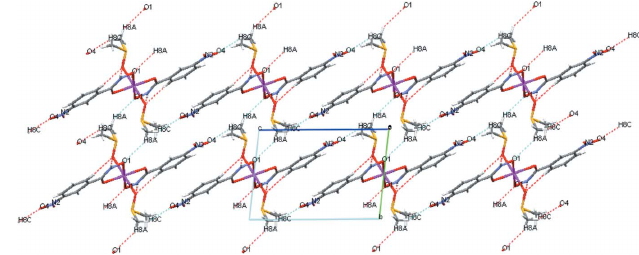
Figure 2 Hydrogen bonding in [Zn(NBZH) 2 (DMSO) 2 ] along the [010] and [001] directions.